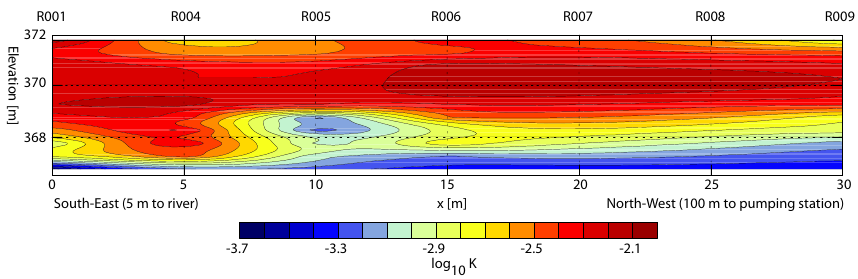
Fig. 10. Hydraulic-conductivity distribution along the pumping-station transect (transect A in Fig. 2) obtained by multi-level slug tests performed in fully penetrating monitoring wells along the transect A. A continuous high hydraulic-conductivity layer is imaged in the upper aquifer, whereas the lower part of the aquifer is characterized by lower hydraulic conductivities.